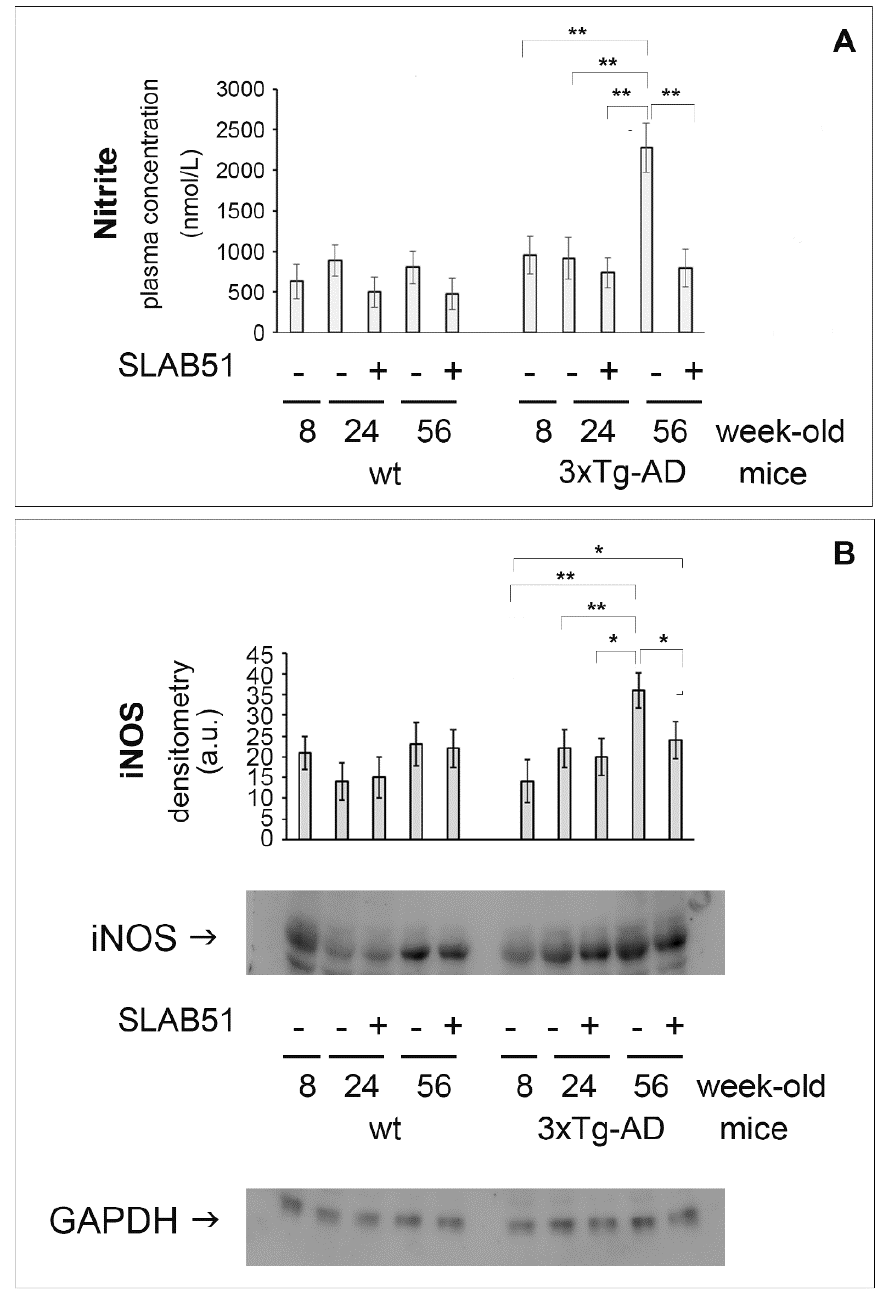
Figure 1. SLAB51 decreased plasma nitrite and iNOS cerebral expression in AD mice. ( A ): Nitrite plasma concentration (nmol/L) in 8-, 24-, and 56-week-old wt (left) and AD (right) mice administered with water or SLAB51. ( B ): Cerebral iNOS expression levels normalized by GAPDH measured in SLAB51-treated (+) and SLAB51-untreated (-) wt (left) and AD (right) mice. The densitometric analyses obtained from three separate blots and representative immunoblots are shown. Equal protein loading was verified by using an anti-GAPDH antibody. The detection was performed with an ECL Western blotting analysis system. Statistical significance compared to untreated 8-week-old mice and age-matched mice is indicated with asterisks (* p < 0.05, ** p < 0.01).